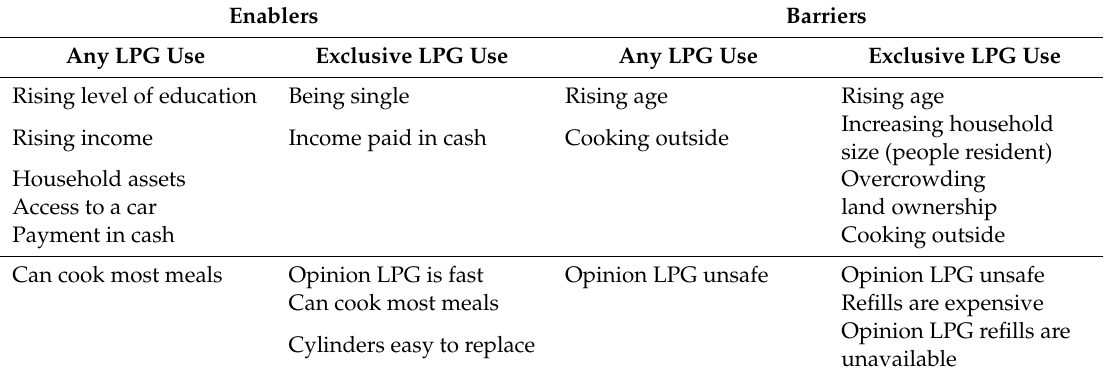
Table 10. Summary of the factors which significantly influence both LPG adoption and exclusive